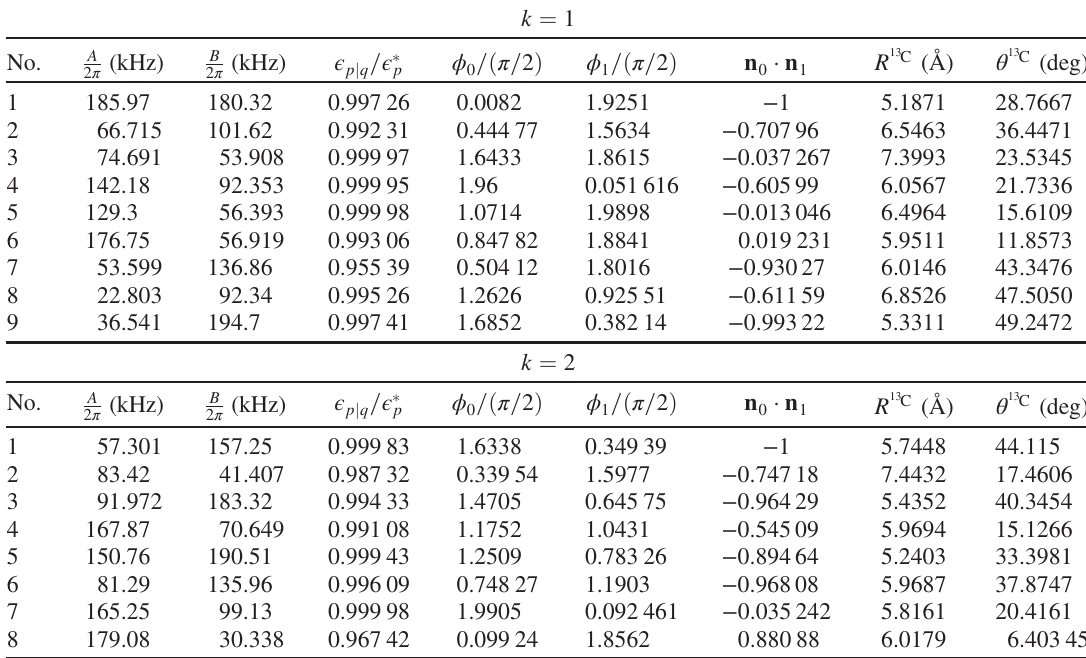
TABLE IV. Parameters for the k ¼ 1 UDD 4 resonance in Figs. 6(i) and 6(j) and the k ¼ 2 UDD 4 resonance in Figs. 6(k) and